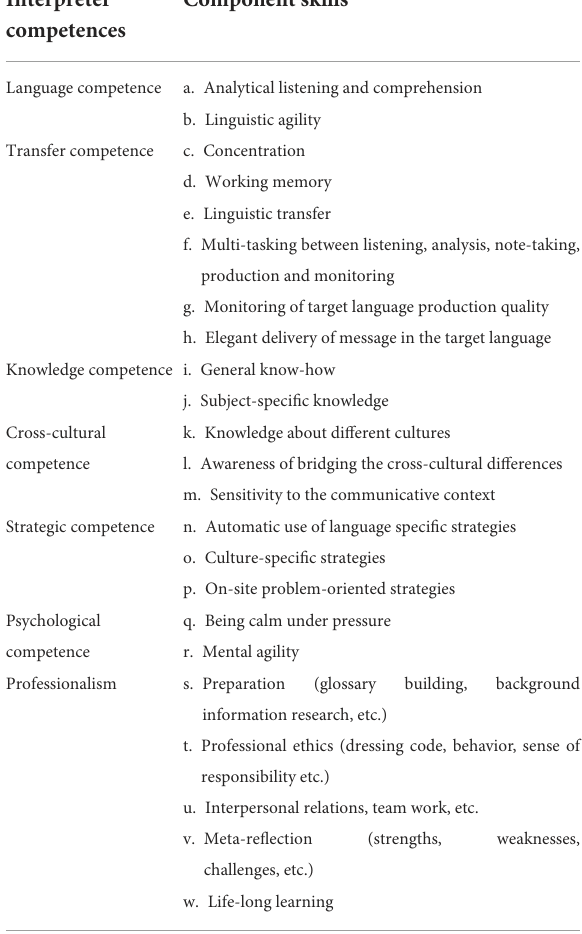
TABLE 4 List of interpreter competences